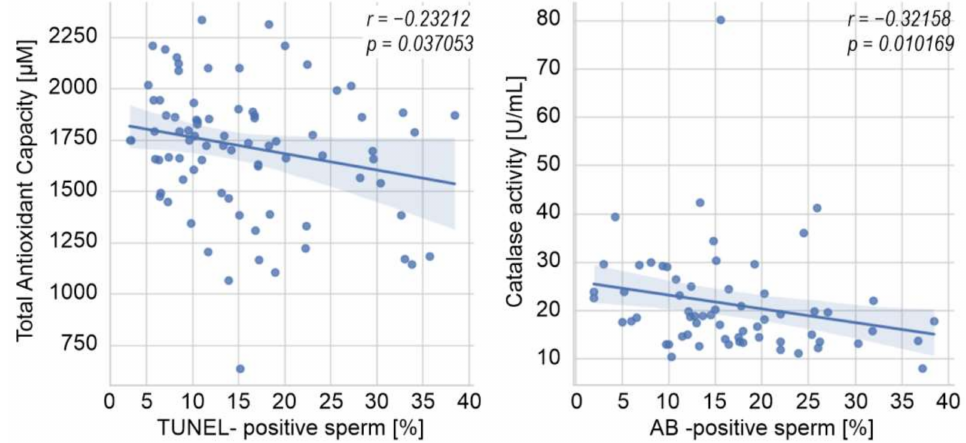
Figure 2. Spearman rank-order correlations between oxidative stress and sperm DNA integrity parameters in the group of infertile men with varicocele. AB—aniline blue, p—p value, r— Spearman’s correlation coefficient.